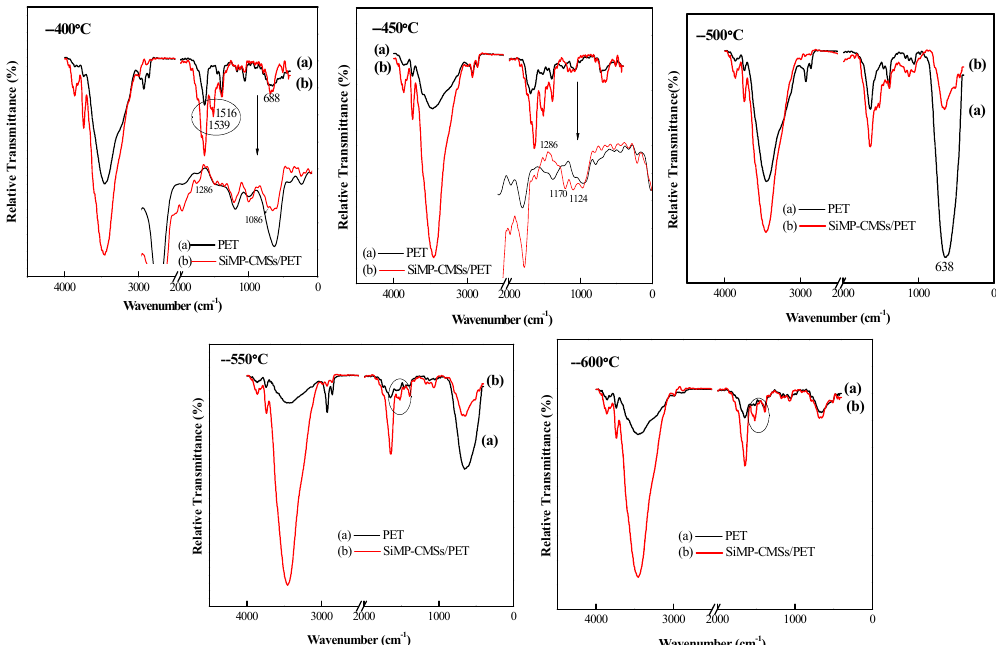
Figure 9. FTIR spectra of the thermal oxidative degradation product of the SiMP-CMSs/PET composites at different temperatures. at different